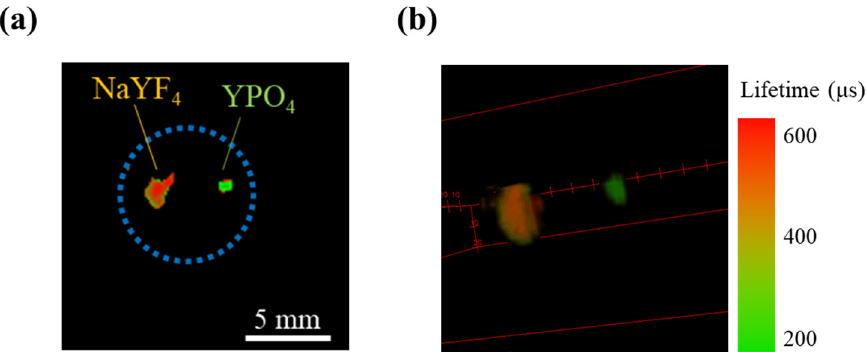
Figure 4. Fluorescence lifetime mapping to cross-sectional and 3D images. ( a ) Cross-sectional images of the fluorescence lifetime difference of NaYF 4 : Nd 3+ , Yb 3+ and YPO 4 : Nd 3+ , Yb 3+ . Blue dotted lines show the outline of the sample. ( b ) 3D images of the fluorescence lifetimes of NaYF 4 : Nd 3+ , Yb 3+ and YPO 4 : Nd 3+ , Yb 3+ . 3D images were obtained by stacking the fluorescence lifetime distributions of the cross-sectional images.